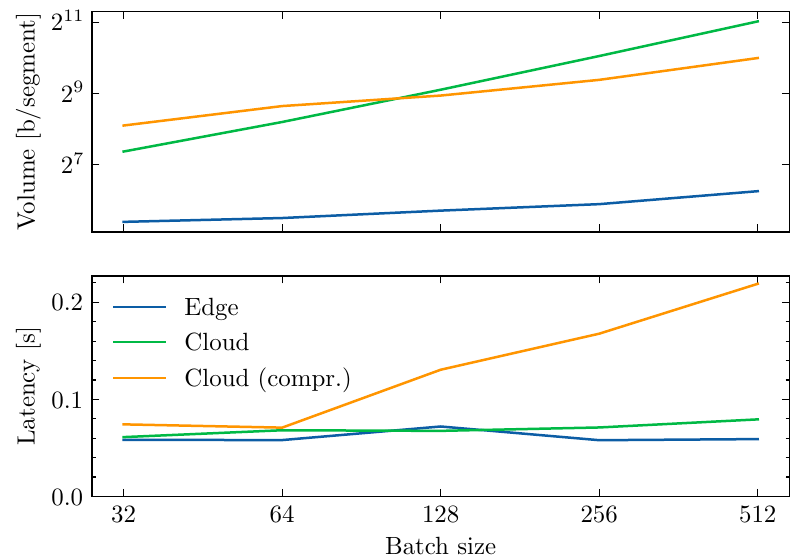
Figure 7. The mean communication latency compared to the volume of transmitted data shows no relationship between them for edge computing and cloud computing without